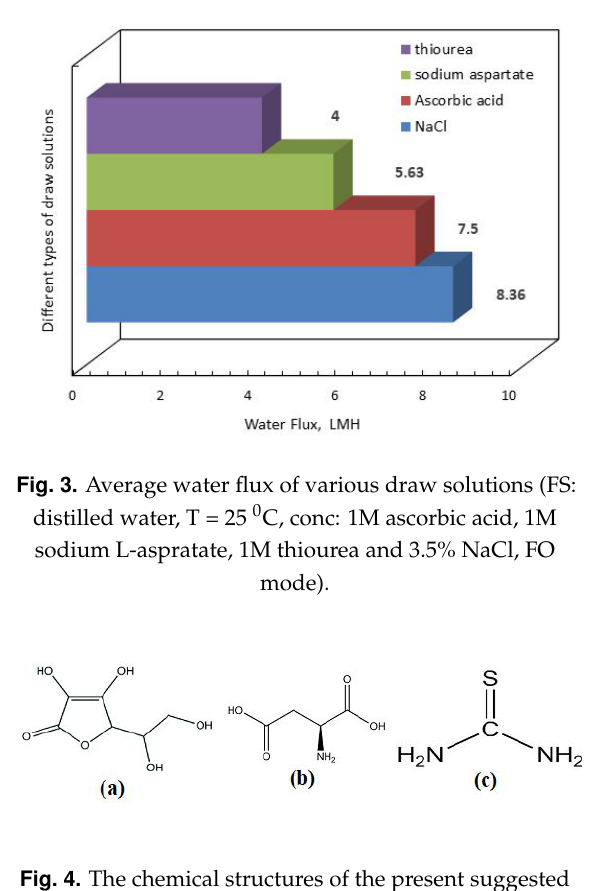
Fig. 4. The chemical structures of the present suggested draw solutions [(a) L-ascorbic acid; (b) L- aspartic acid; (c)